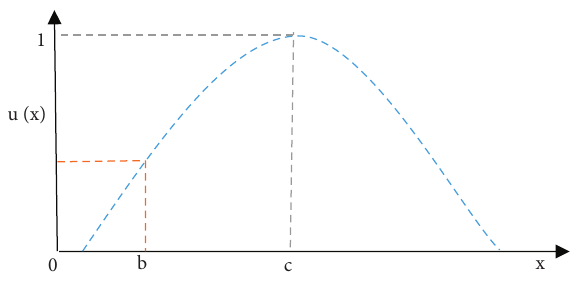
Figure 10: The Gaussian fuzzy membership